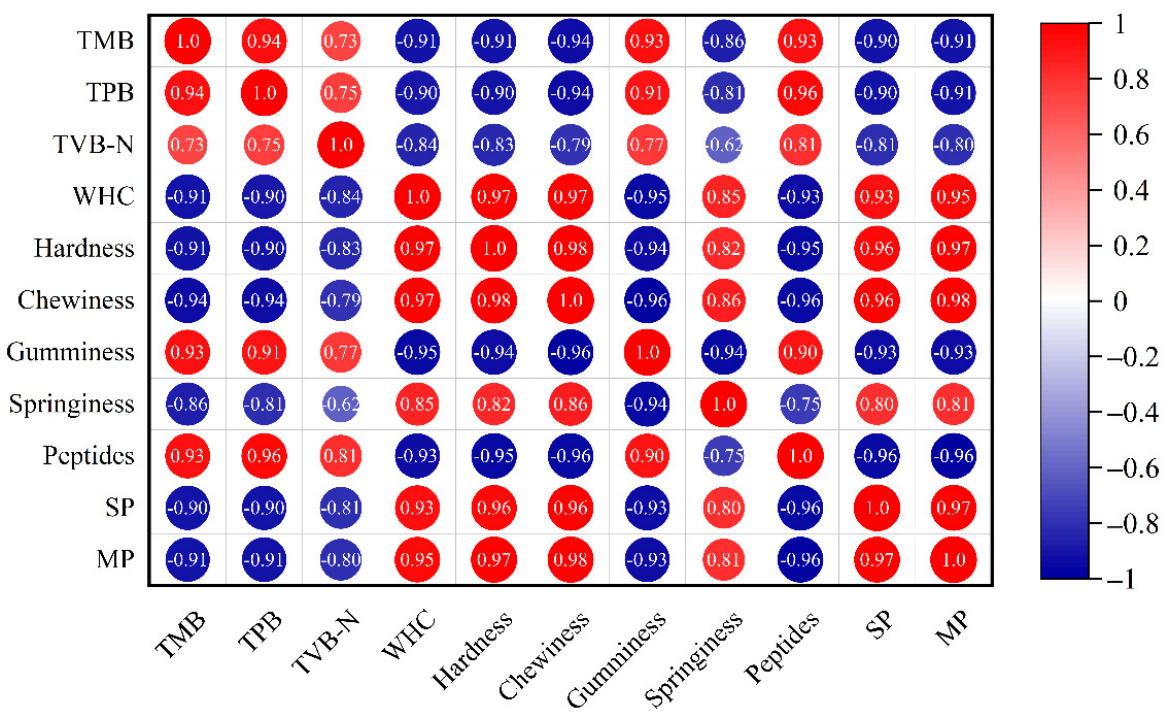
Figure 6. Heatmap of Pearson correlation between the TMB, TPB, TVB-N, WHC, hardness, chewiness, gumminess, springiness, TCA-soluble peptides, sarcoplasmic and myofibrillar protein content in salmon under modified atmosphere packaging. The circle size represents the absolute value of the correlation coefficient, where red represents positive correlation, and blue represents negative correlation.